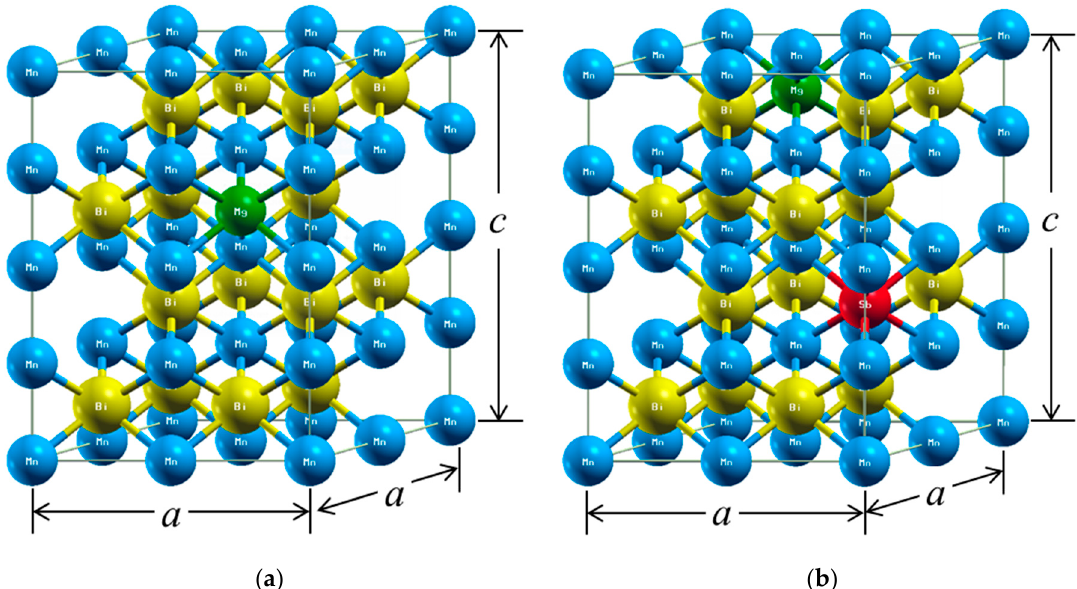
Figure 9. Crystal structures of ( a ) Mn 16 Bi 15 Mg (or Sb) and ( b ) Mn 16 Bi 14 SbMg used for the first-principles calculations. The Mn, Bi, Mg, and Sb atoms are in blue, yellow, green, and red, respectively. Nanomaterials 2020 , 10 , x FOR PEER REVIEW